Question: Describe this figure in one sentence.
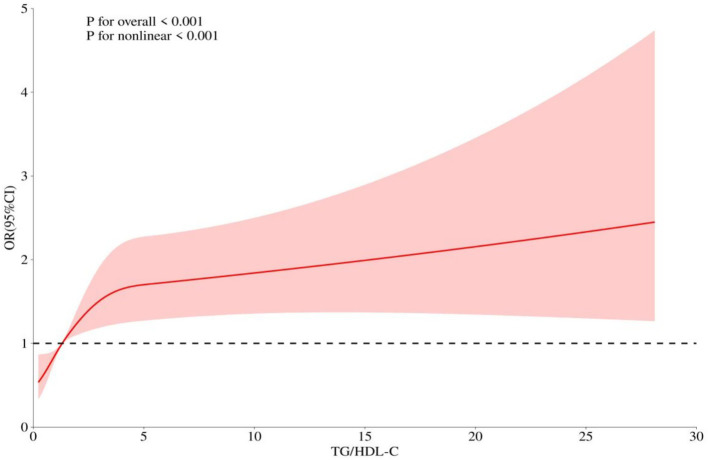
Answer: Restricted cubic spline (RCS) analysis of the relationships between TG/HDL-C and albuminuria. The solid line represents the OR, with the shaded area representing the 95% CI. Adjustments were made to the model for age, gender, smoking status, drinking status, hyperlipidemia, hypertension, e-GFR, BMI, HbAlc and HOMA-IR.